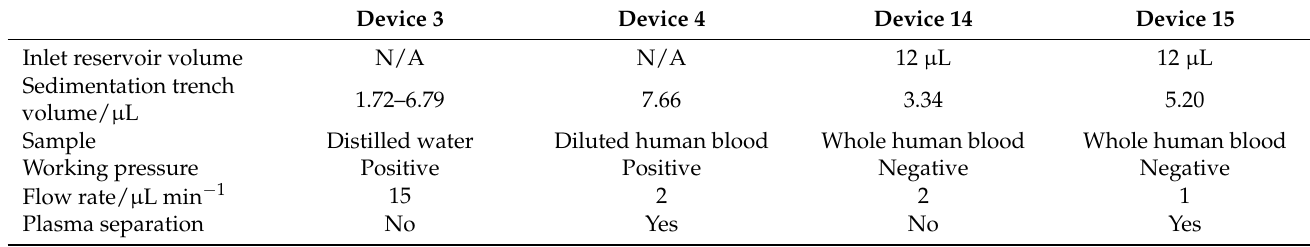
Table 2. Performance specifications of Devices 3, 4, 14 and